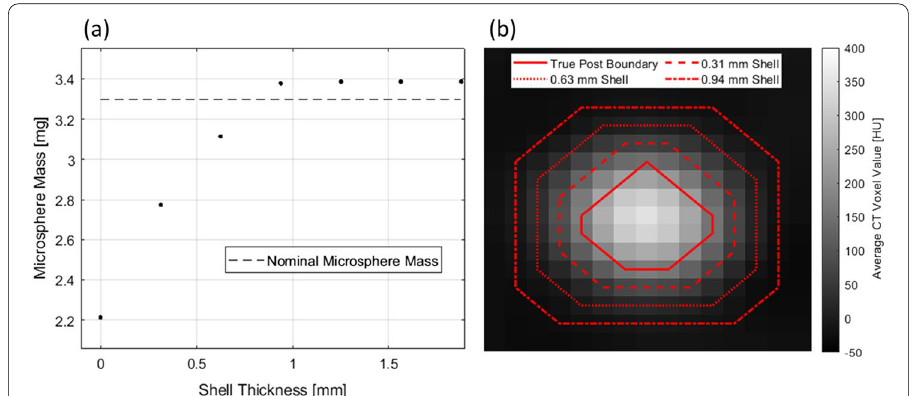
Fig. 6 a The microsphere mass in the 2 mm-diameter post with a microsphere concentration of 25.0 mg/ mL as a function of contour shell thickness. The nominal mass of Eye90 within the contour is represented by the dashed horizontal line. b Axial CT slice [ 50 to 400 HU] of the 2 mm-diameter post with a microsphere − concentration of 25.0 mg/mL. The red contours represent extended shell